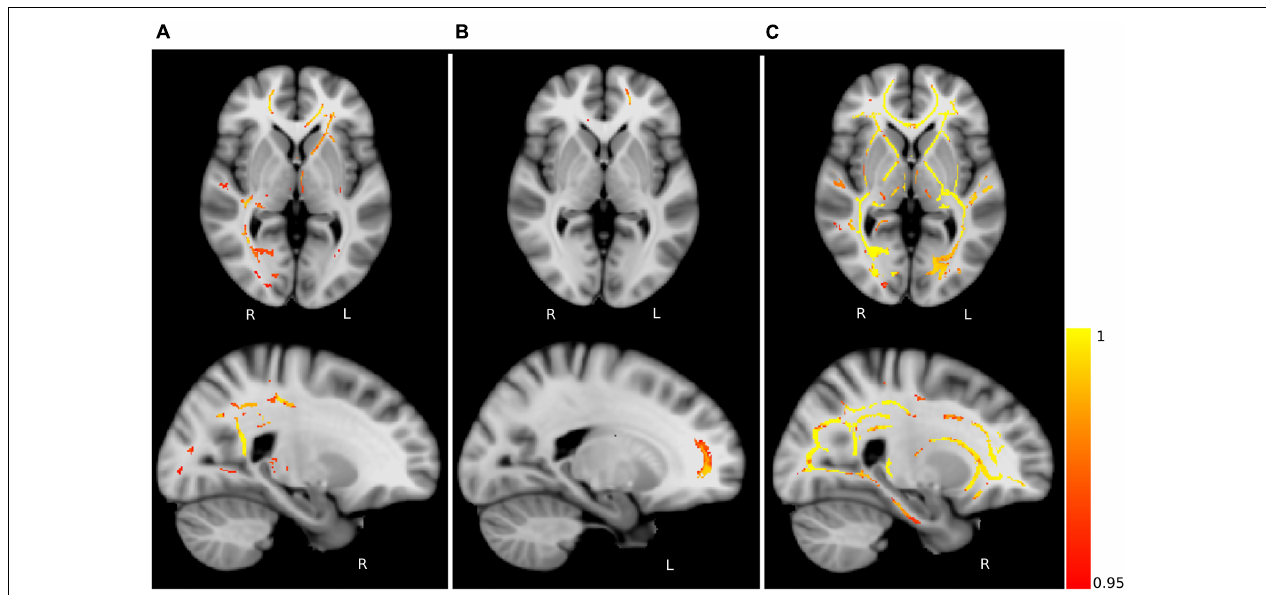
FIGURE 4 | Fractional anisotropy (FA) differences. Axial and sagittal slices showing significant differences between (A) young and middle-aged healthy controls (HC Y > HC M ), (B) middle-aged healthy controls and PD patients (HC M > PD) and (C) young healthy controls and PD patients (HC Y > PD). The slices show the threshold-free cluster enhancement (TFCE) thresholded results ( p < 0.05, FWE corrected) superimposed on the FSL’s 1 mm MNI152 standard brain. The scale [1 – p -value] represents the significance of the clusters with yellow indicating higher and red indicating lower statistical significance. L and R denote the left and right hemisphere of the brain.